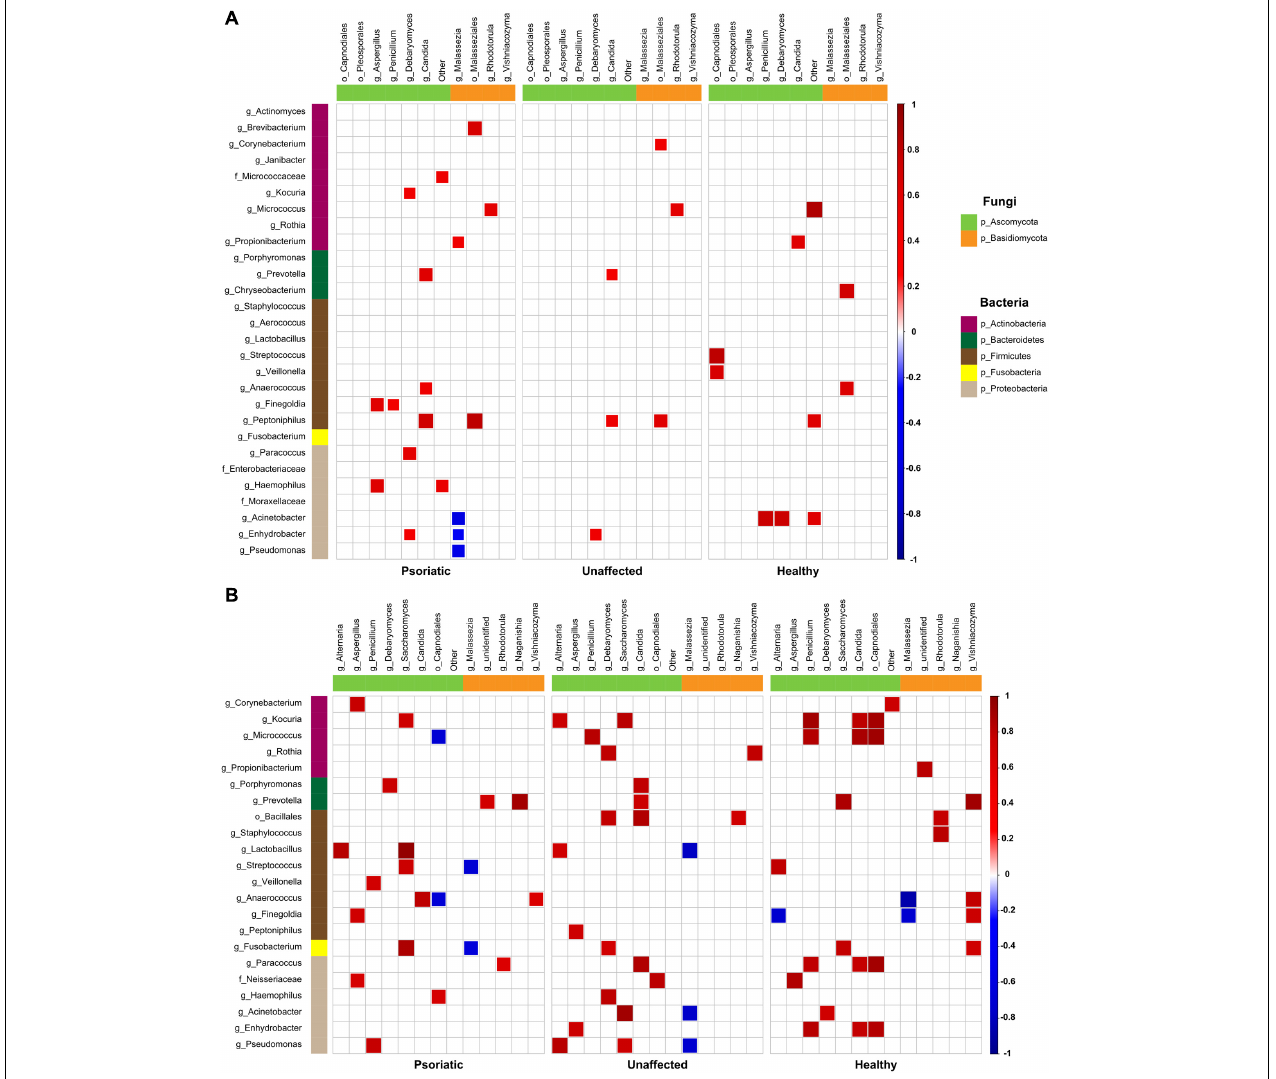
FIGURE 4 | Bacteria–fungi correlation pattern in relation to psoriatic, unaffected or healthy control skin. Pearson correlation for the relative abundances of bacterial and fungal populations on the back (A) and elbow skin (B) . Correlations were calculated separately for each group of samples – psoriatic skin (left), unaffected skin (middle), and healthy skin (right). Positive correlations are represented by red squares; negative correlations are represented by blue squares, while insignificant correlations ( p > 0.05) are blank.